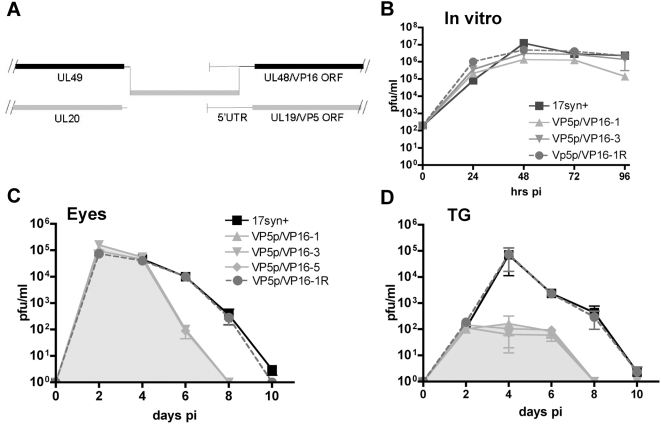
Replication of VP5p/VP16 mutants in vitro and in vivo.(A) A diagram of the construction of the VP5p/VP16 mutants is shown. The
VP16 promoter and 5′UTR sequences were replaced with those of
another gene expressed with leaky late kinetics, the VP5 gene, as
detailed in Methods. (B) RSC were
infected with mutants VP5/VP16-1 and -3, the genomically restored
isolate (VP5p/VP16-1R), and wild type HSV-1 strain 17Syn+ at an
moi of 0.0004 pfu/cell. At the indicated times, 3 plates infected with
each virus were harvested and assayed independently for virus content as
detailed in Methods. (C,D) Mice
were infected as detailed in Methods and, at the indicated times pi, tissues from three mice
from each group were assayed for virus content. The grey shading in C
and D indicates the regions employed to calculate the areas under the
curves for the VP5p/VP16 mutants.